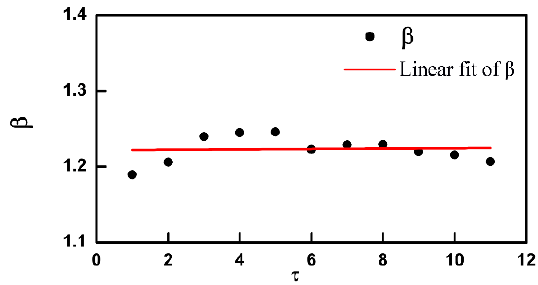
Figure 3. The changes of β with different lengths of time series.